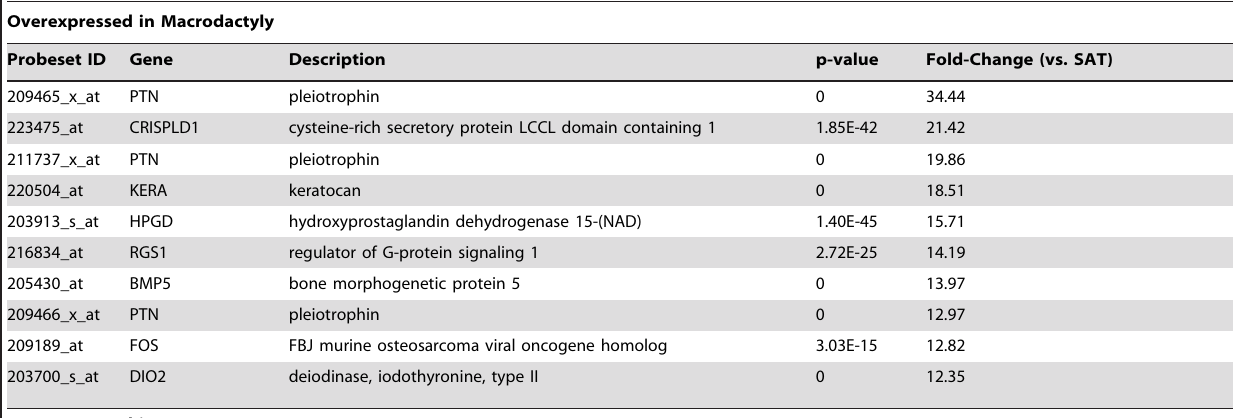
Overexpressed in Macrodactyly Probeset ID